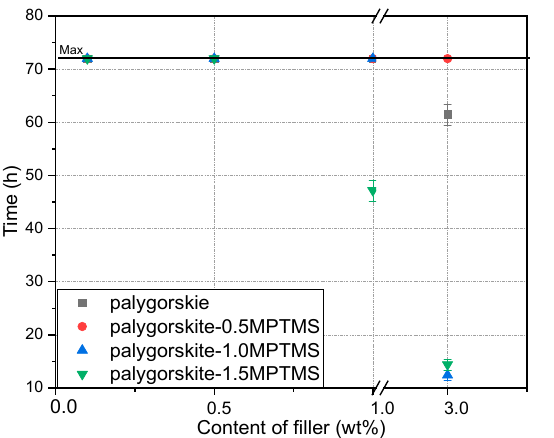
up to 72 h for fillings from 1.0 wt.%.